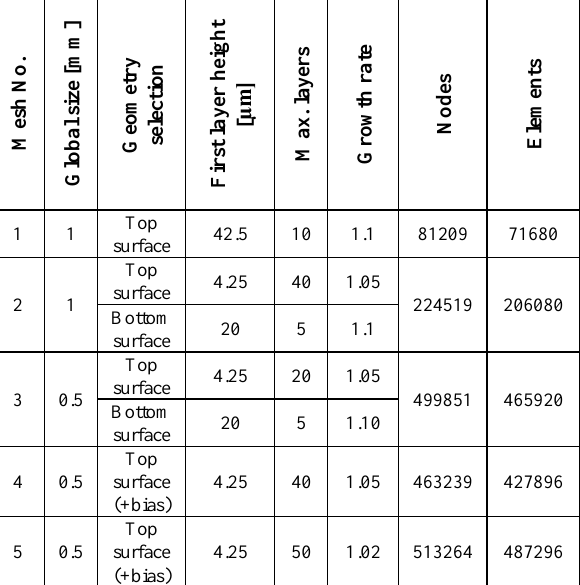
Table 1. Details of mesh refinement.